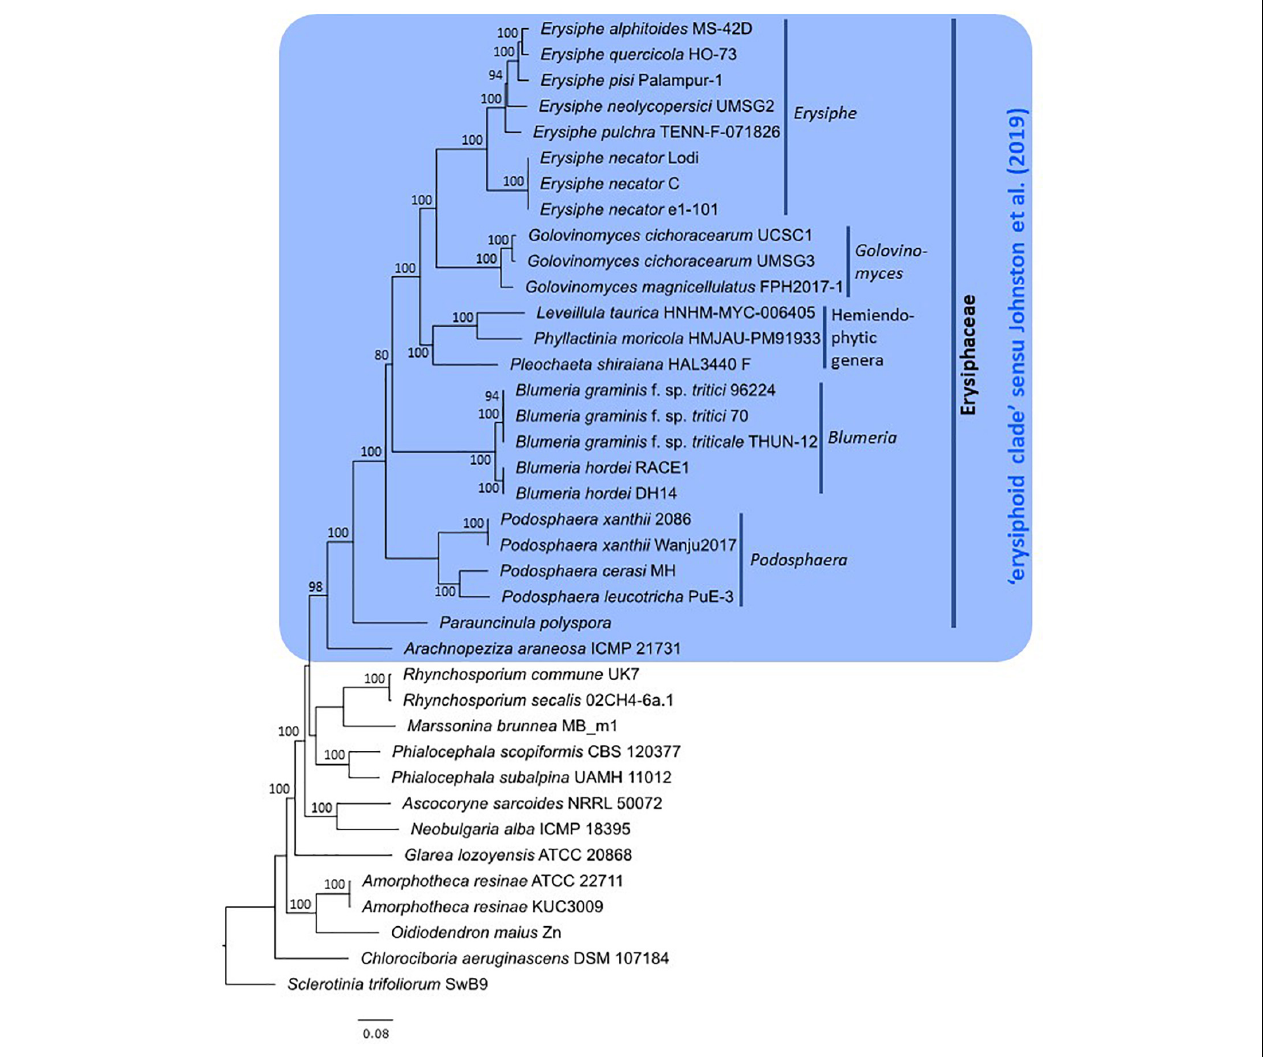
FIGURE 1 | Phylogeny of powdery mildew species and closely related Leotiomycetes based on 751 orthologous protein sequences. Maximum likelihood phylogeny was inferred from a concatenated alignment of amino acid sequences using RAxML-NG v.1.0.1 (Kozlov et al., 2019) under the JTT+I+G4+F substitution model. Taxon labels include species names followed by the specimen/strain accession numbers, except for Parauncinula polyspora , for which a herbarium specimen is not available (Frantzeskakis et al., 2019a). Bootstrap support values greater than 70% are shown at the edges. The tree is rooted to Sclerotinia trifoliorum strain SwB9 (Kusch et al., 2022b). The scale bar represents nucleotide substitutions per